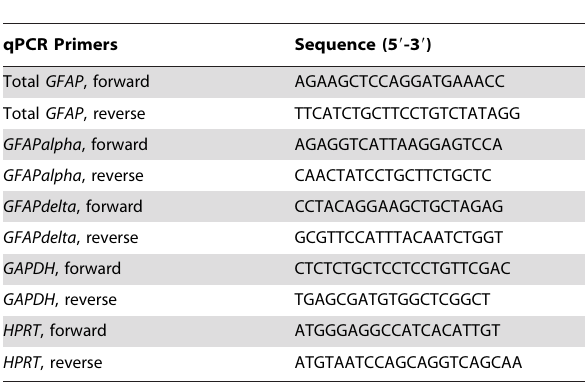
Table 5. List of the genes quantified by QRT-PCR